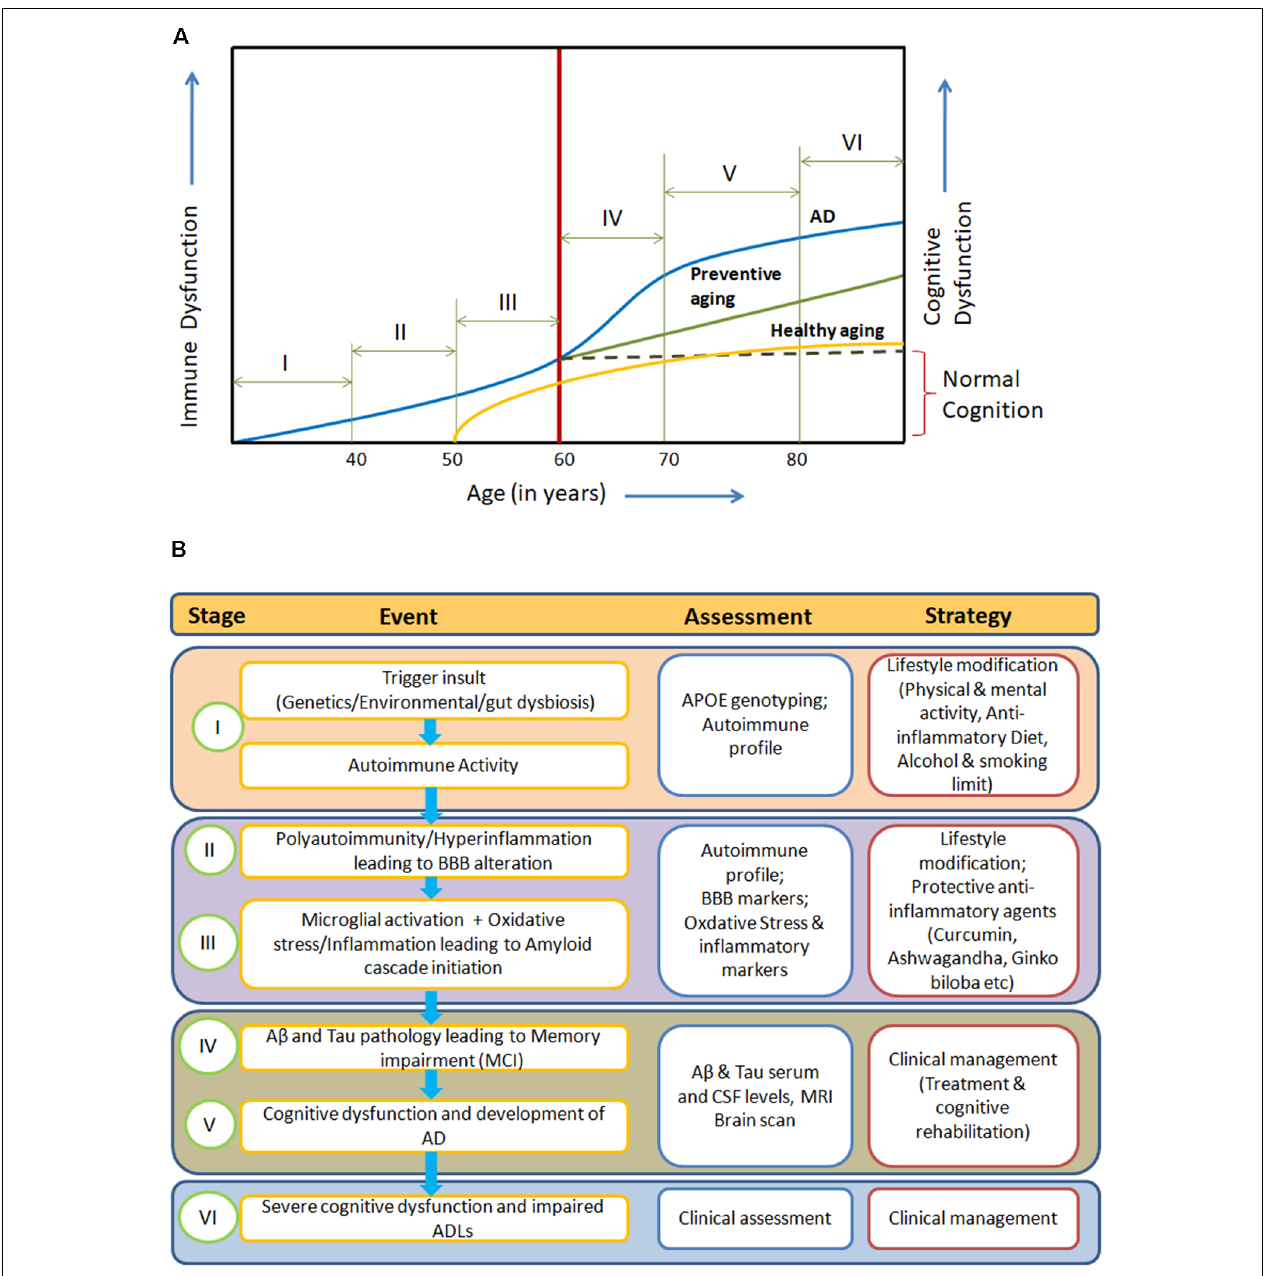
FIGURE 1 | (A) Systemic Immune Dyshomeostasis Model representing stages leading to the development and progression of Alzheimer’s disease (AD). (B) Possible assessment and prevention strategy at different stages of AD model. The blue line in (A) represents stages and events leading to AD. In response to different trigger insults, over years, the autoimmune activity begins to increase in the humans due to immunosenescence gradually from around 30 years of age (Stage I). Further, progression in immune impairment due to repeated trigger insults may be attributed to polyauoimmunity/hyperinflammation, which leads to blood-brain barrier (BBB) dysfunction and then amyloid cascade activation through microglial activation and oxidative stress (stage II and III). Inflammation, autoimmune activity and BBB alterations (at stages I and II) are known to be associated with amyloid oligomers and tau pretangles. Abeta and tau pathology in the form of soluble oligomers and pretangles or paired helical fragments could be present at middle age (40–50) without causing clinical cognitive decline (stages II and III). In the absence of any preventive action, irreversible immune dysfunction cascade begins along with amyloid and tau pathological changes (around 60 years), leading to cognitive impairment (Stage IV). Activation of dyshomeostatic events leads to faster decline in immune functions and cognitive functions, resulting in the development of AD (Stage V). These systemic immune dyshomeostatic events can be controlled through periodic assessment and lifestyle modifications along with the use of neuroprotective/immune strengthening anti-inflammatory agents, which signifies “Preventive aging” (green line). The “Healthy aging” (yellow line) shows the ideal condition where there is neither any predisposing risk factor nor exposure to pathological trigger insults. Only aging-related immune dysfunction appears at late age with slow decline and mild cognitive impairment in cognitive